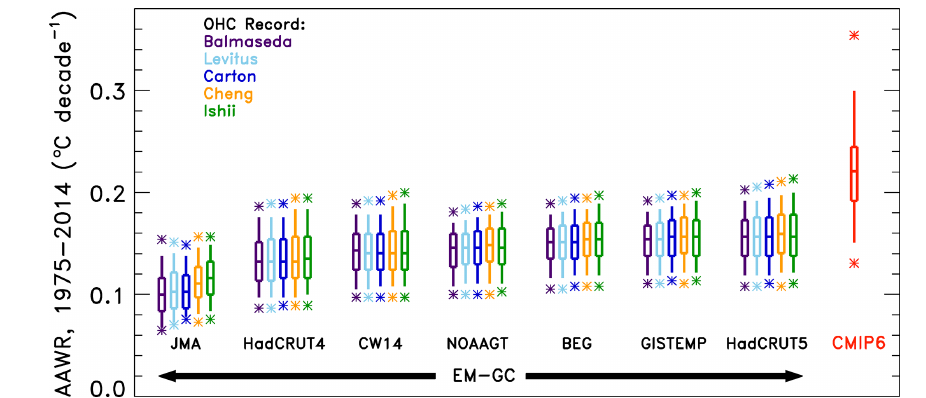
Figure 6. AAWR from the EM-GC and CMIP6 multi-model ensemble for 1975–2014. Seven temperature data sets and five ocean heat content records are used to compare values of AAWR computed from the EM-GC. The box represents the 25th, 50th, and 75th percentiles, the whiskers denote the 5th and 95th percentiles, and the stars show the minimum and maximum values of AAWR from the EM-GC based on the aerosol weighting method described in Sect. 2.5. The red box labeled “CMIP6” shows the 25th, 50th, and 75th percentiles, the whiskers represent the 5th and 95th percentiles, and the stars denote the minimum and maximum values of AAWR from the 50-member CMIP6 multi-model